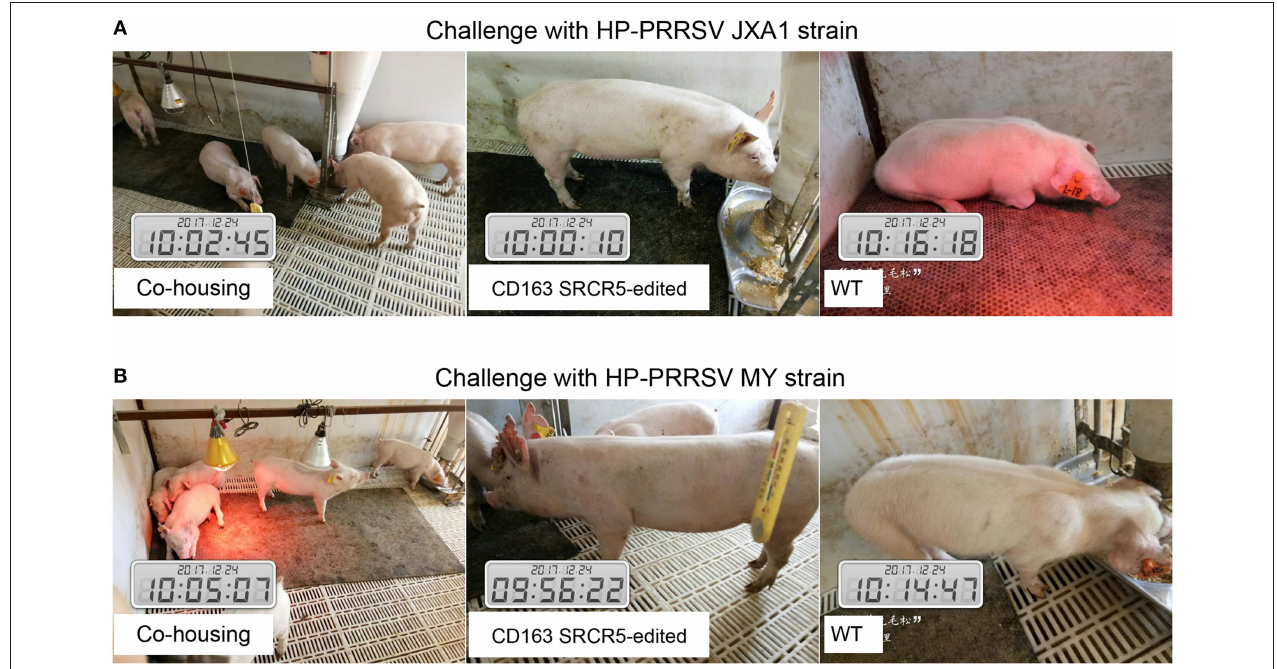
FIGURE 3 | CD163 SRCR5-edited pigs do not show clinical symptoms after PRRSV challenge. (A,B) Sixteen piglets were divided into two groups, of which four CD163 SRCR5-edited Large White piglets and four WT piglets were mixed as a group. These piglets were co-housed and given access to food and water ad libitum . One group was challenged with the PRRSV JXA1 strain (A) , the other group was challenged with the PRRSV MY strain (B) . Clinical signs related to PRRSV, including respiratory and neurological symptoms, were observed and recorded every day post challenge. Pictures were taken on day 21 post challenge.